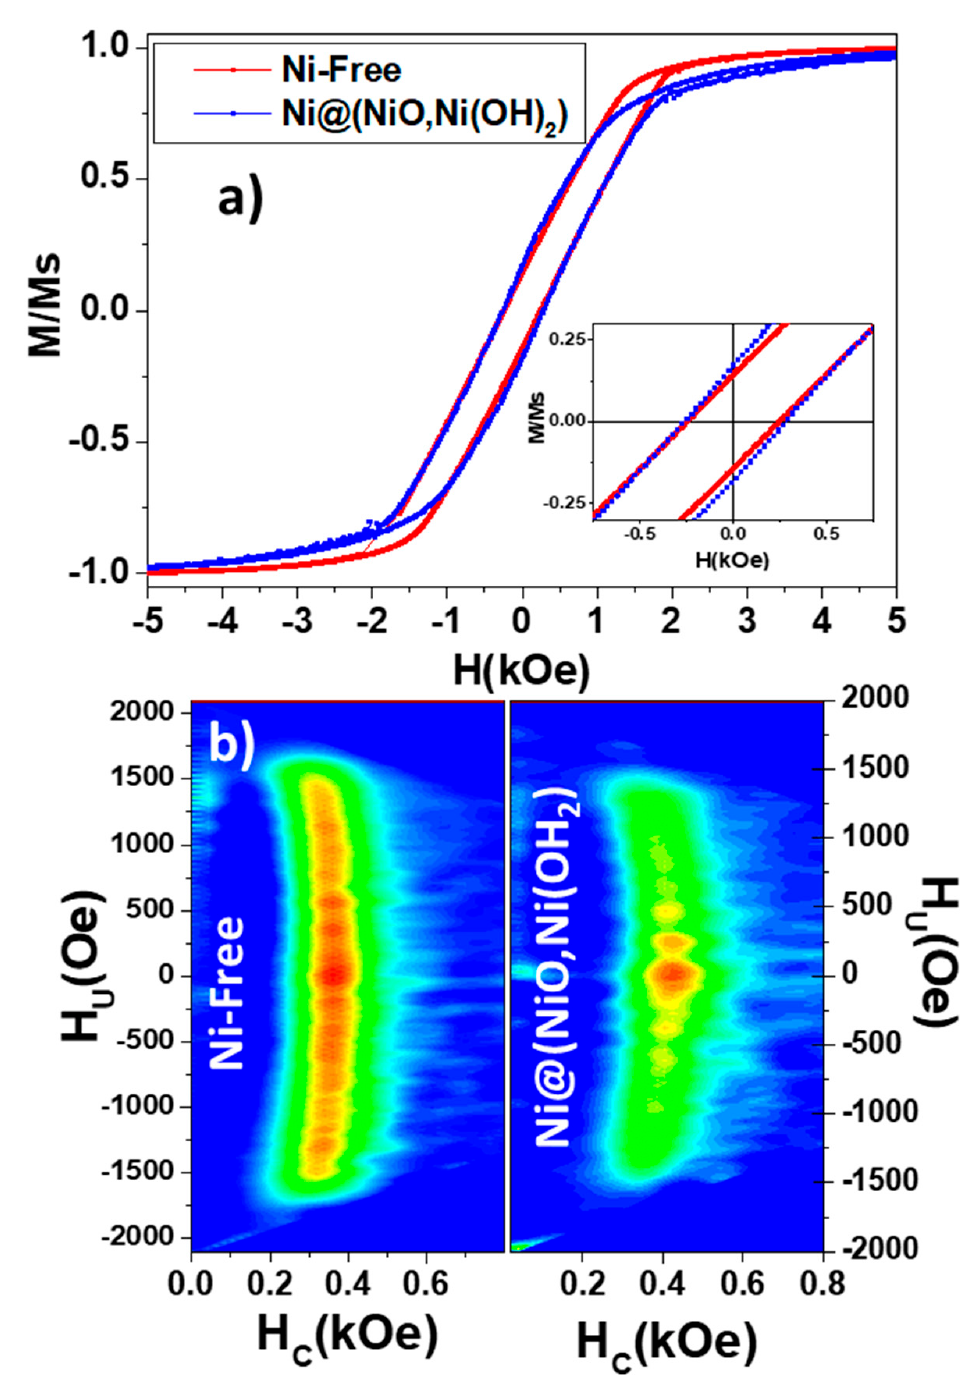
Figure 6. ( a ) Room-temperature magnetic hysteresis loops of Ni-Free (red) and Ni@(NiO,Ni(OH) 2 ) (blue) samples with the magnetic field applied along the nanowire’s long axis. ( b ) FORC diagrams of Ni-Free ( left ) and Ni@(NiO,Ni(OH) 2 ) ( right ) samples.